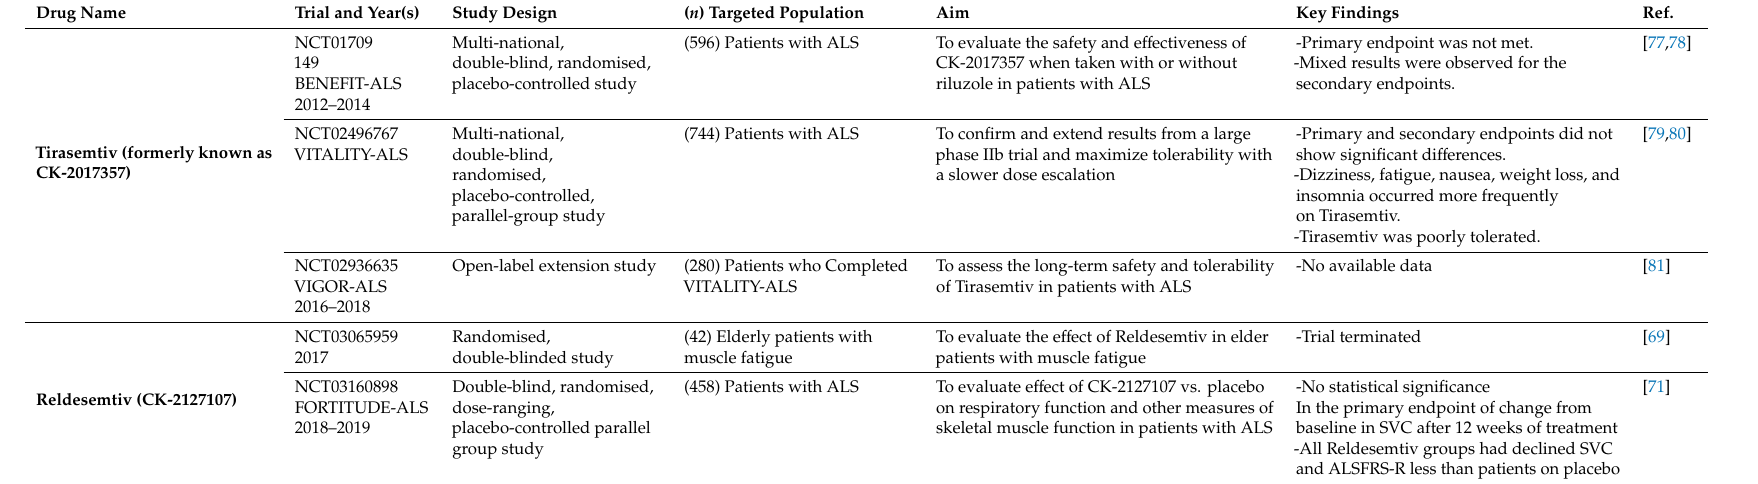
Table 3. Overview of reported key clinical trials on skeletal muscle